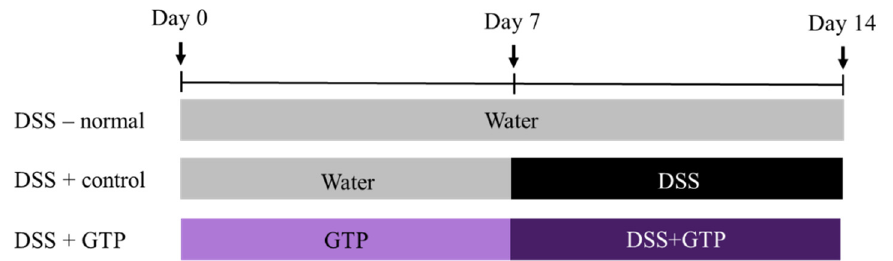
Figure 1. Experimental design for the administration of green tea extract containing Piper retrofractum (GTP) and dextran sulfate sodium (DSS).